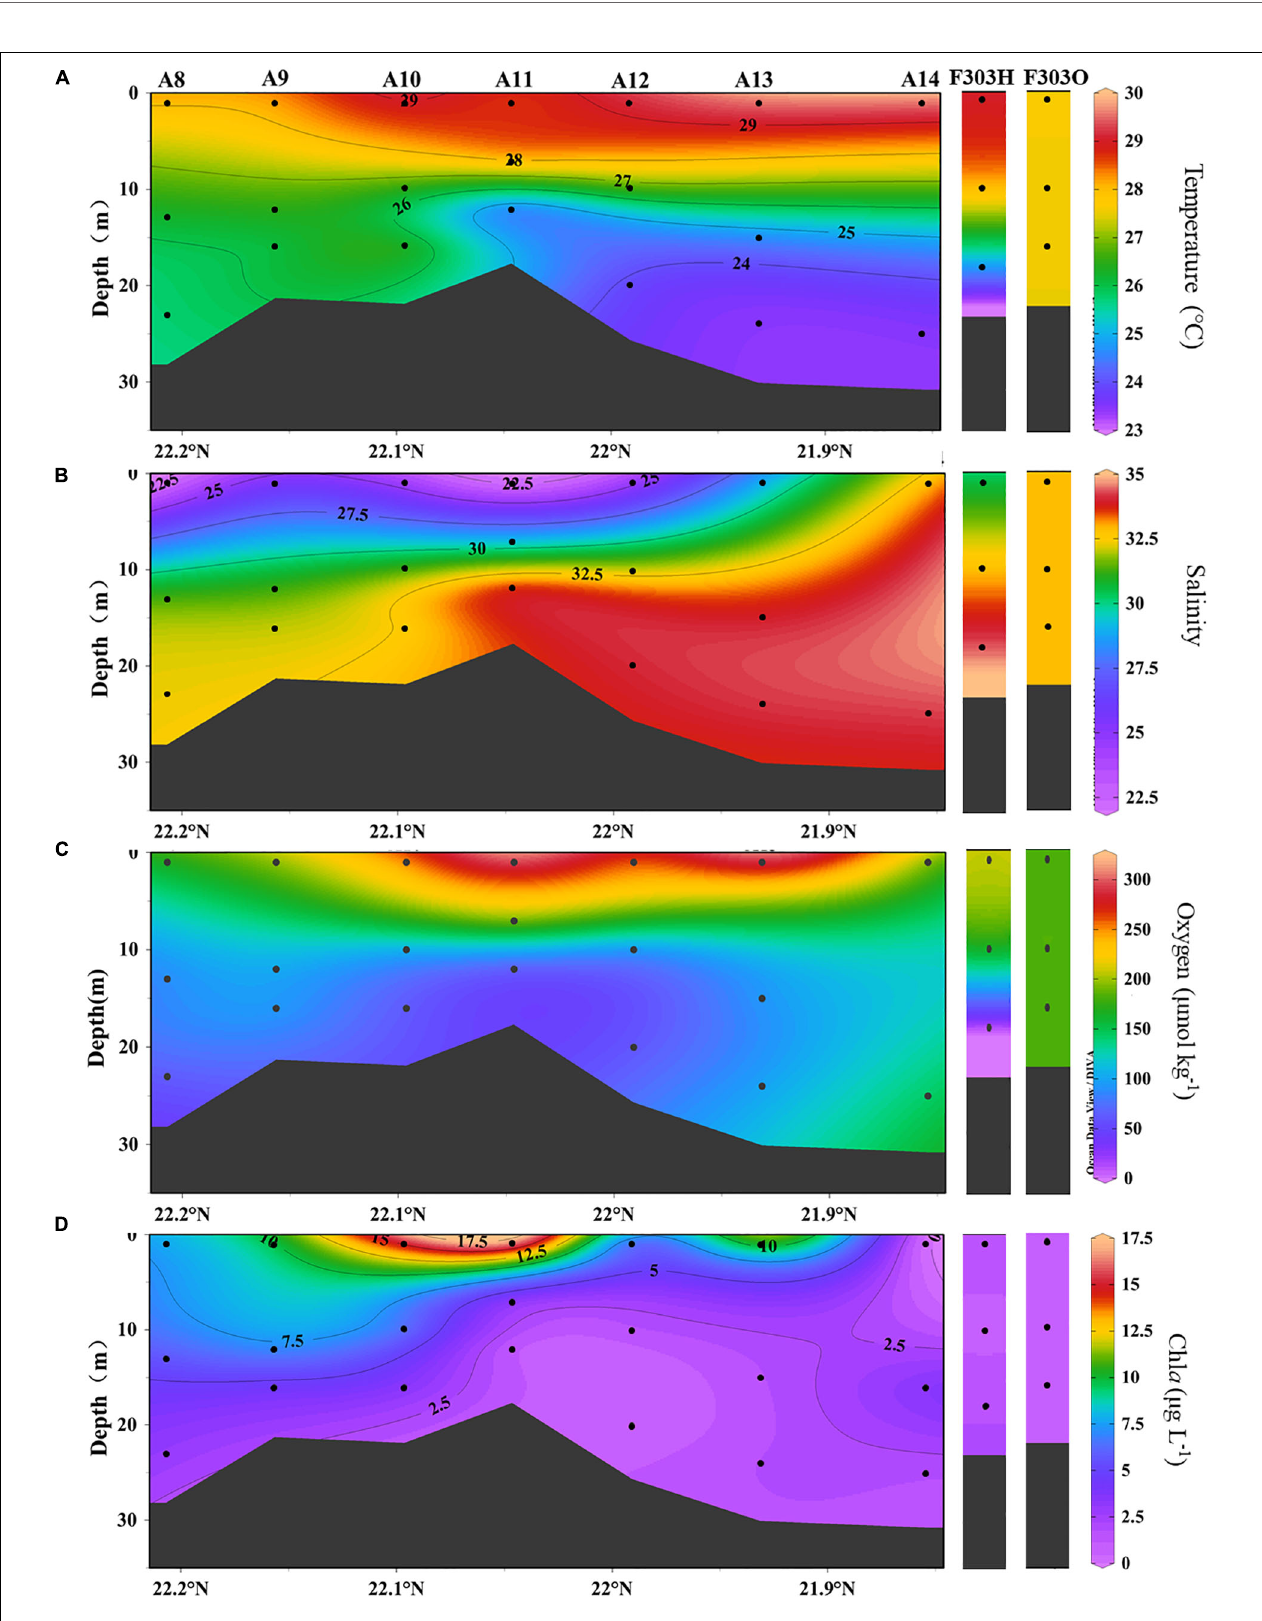
FIGURE 2 | Distribution of (A) temperature, (B) salinity, (C) dissolved oxygen, and (D) chl a at transect A and station F303 on the NSCS shelf. Station F303H and F303O are the two visits to station F303 before and after Tropical Storm Son-Tinh, respectively.